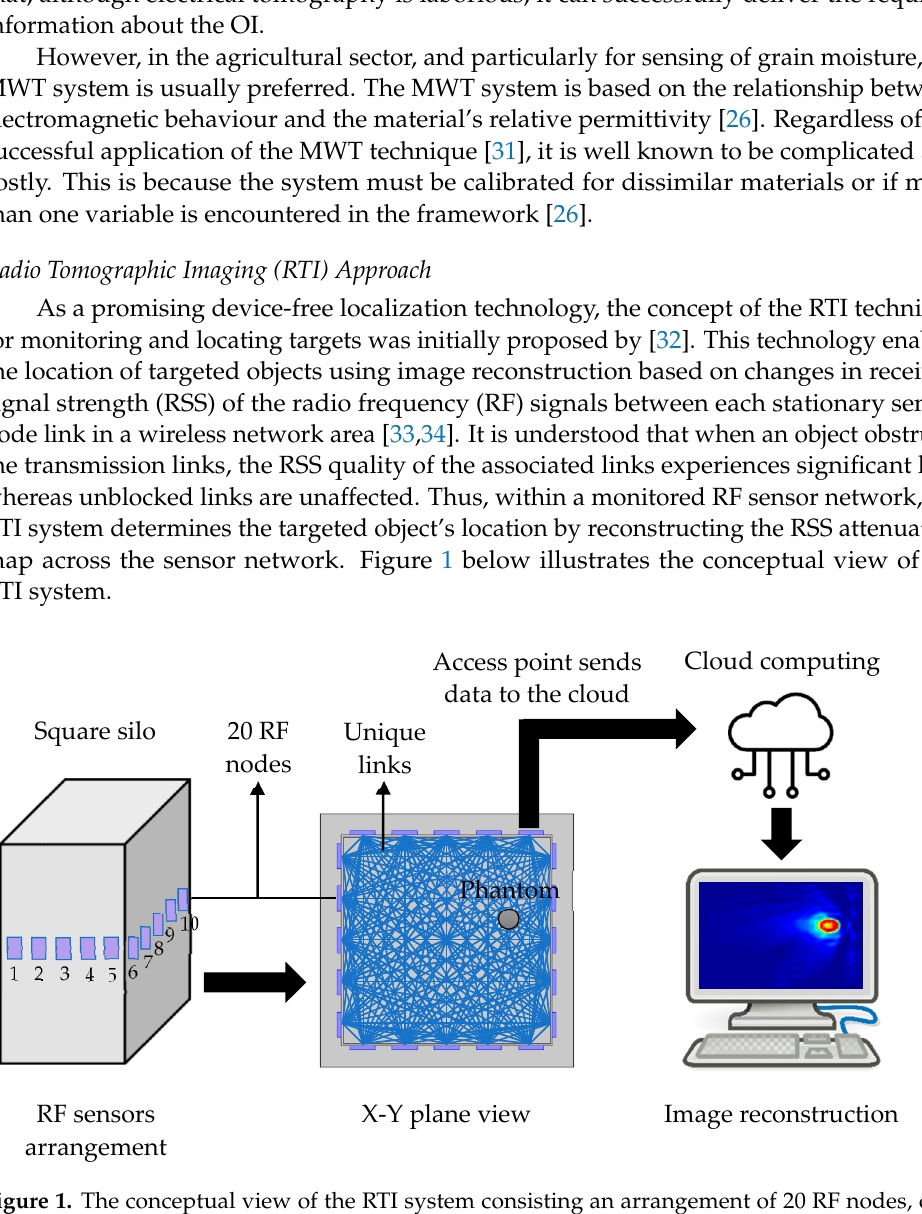
Figure 1. The conceptual view of the RTI system consisting an arrangement of 20 RF nodes, data acquisition process, and image reconstruction system.